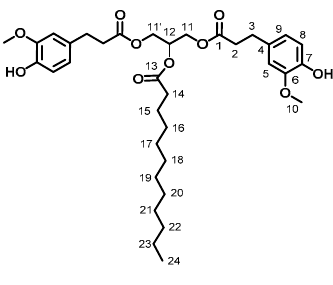
Figure 3. GDF 10 . Figure 3. GDF 10. Figure 3. GDF 10.